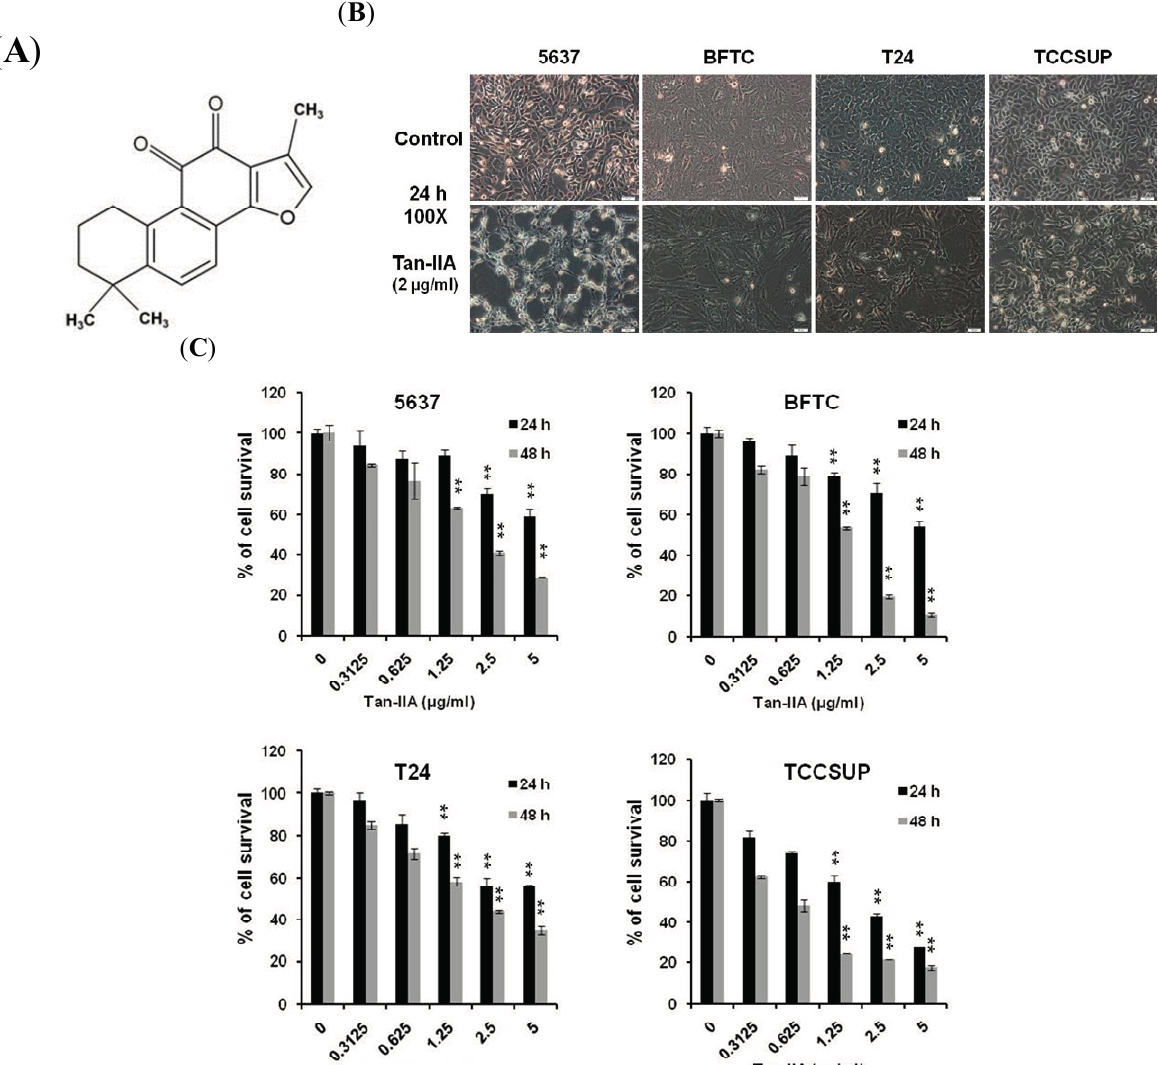
various bladder cancer cell lines in a dose- and time-dependent manner (Figure 1C). Treatment of 5637 cells with 2.5 μ g/mL Tan-IIA for 24 and 48 h resulted in 70.3% and 40.7% cell survival, respectively. Treatment of BFTC cells with 2.5 μ g/mL Tan-IIA for 24 and 48 h resulted in 70.6% and 19.7% cell survival, respectively. Treatment of T24 cells with 2.5 μ g/mL Tan-IIA for 24 and 48 h resulted in 56.3% and 43.8% cell survival, respectively. Treatment of TCCSUP cells with 2.5 μ g/mL Tan-IIA for 24 and 48 h resulted in 43% and 21.3% cell survival, respectively. The IC 50 at 48 h of Tan-IIA treatment in bladder cancer cells were: 5637, 2.6 μ g/mL; BFTC, 2 μ g/mL; T24, 2.7 μ g/mL; TCCSUP, 1.4 μ g/mL, respectively. Figure 1. Effects of Tan-IIA on the viability of human bladder cancer cells. ( A ) Chemical structure of Tan-IIA, C 19 H 18 O 3 , molecular weight: 293.34; ( B ) Human bladder cancer cells (5637, BFTC, T24 and TCCSUP) were treated with 0.2% DMSO as control or 2 μ g/mL Tan-IIA for 24 h, were shown; Scale bar: 50 μ m; ( C ) Human bladder cancer cells were treated with increasing concentration of Tan-IIA (0.3125 to 5 μ g/mL) for 24 (black bar) and 48 h (gray bar), respectively, and the survival rate was evaluated with MTT assay. Data are presented as means ± S.D. obtained from three different experiments. ** p < 0.01 versus